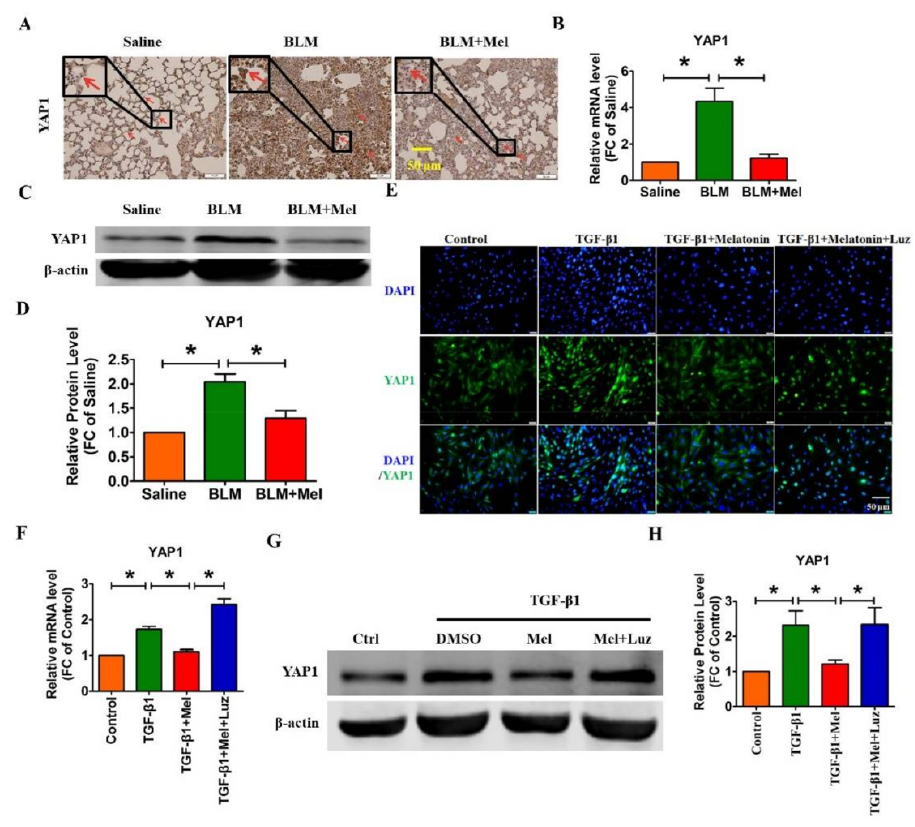
Figure 4. Dysfunction of YAP1 is involved in the anti-fibrotic effect of melatonin in BLM-treated mice. ( A ) The expression of YAP1 was down-regulated after treatment with melatonin, determined with immunohistochemical staining; red arrow indicated the expression of YAP1. ( B ) qRT-PCR analysis of the mRNA expression of YAP1 in BLM-mice. β -Actin mRNA acted as the internal control; n = 6 mice in each group. ( C , D ) Western blot analysis of YAP1 and the related statistical data are shown. ( E ) Immunofluorescence assay to determine the effect of melatonin and luzindole on the location of YAP1 in lung fibroblasts. qRT-PCR ( F ) and Western blot ( G , H ) assays were performed to evaluate the effect of melatonin and luzindole on the mRNA and protein level of YAP1. β -Actin served as the internal control. Values are the mean ± SEM of five independent experiments. * p <